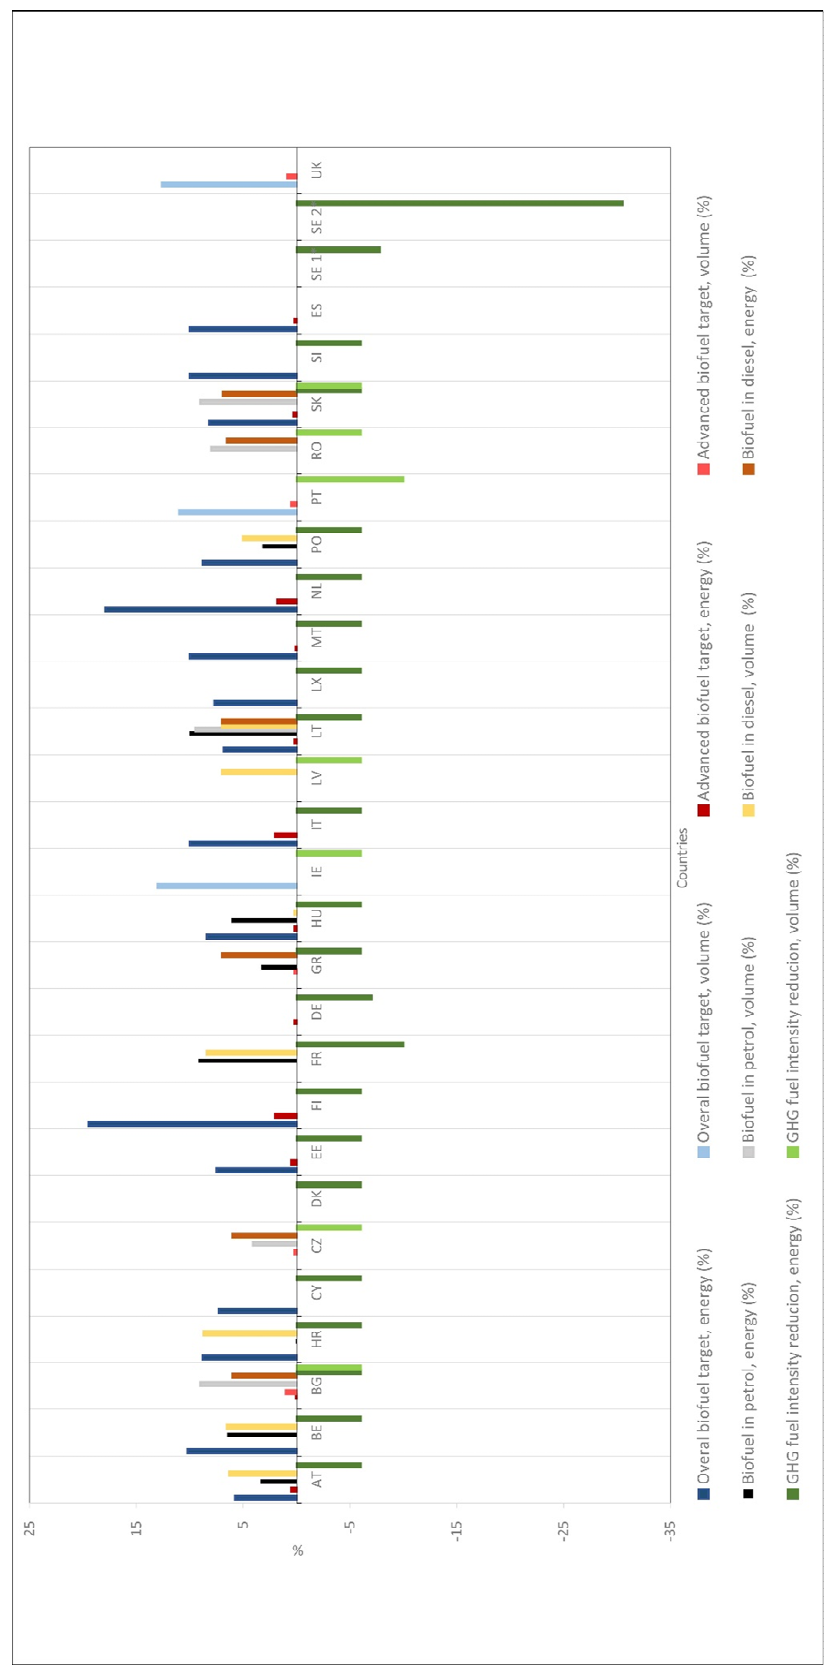
Figure 1. Biofuels targets in the EU (according to [8]).